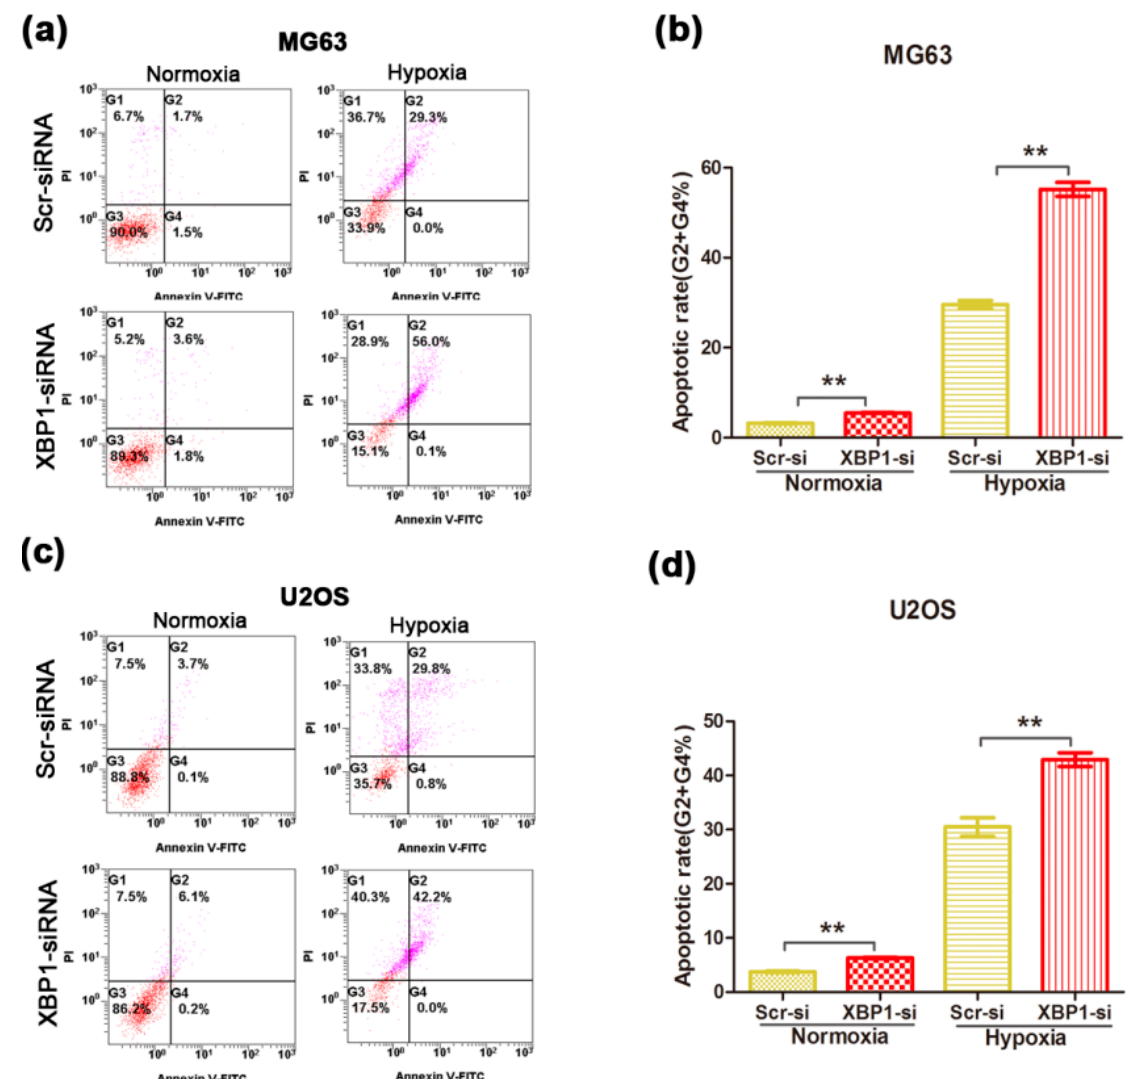
Figure 4. Knockdown of XBP1 increased the apoptosis rate of OS cells under both normoxic and hypoxic condition. ( a , b ) Comparison of apoptosis between Scramble and XBP1-knockdown group in MG63 under normoxic and hypoxic condition; ( c , d ) Comparison of apoptosis between Scramble and XBP1-knockdown group in U2OS under normoxic and hypoxic condition. The data represent mean ± s.d. of triplicate ( b , d ). ** p < 0.01 by Student’s t -test. The cells were transfected with XBP1 siRNA (50 nM) for 48 h, and treated with or without hypoxia (1% O 2 ) for 24 h. All the apoptotic rates